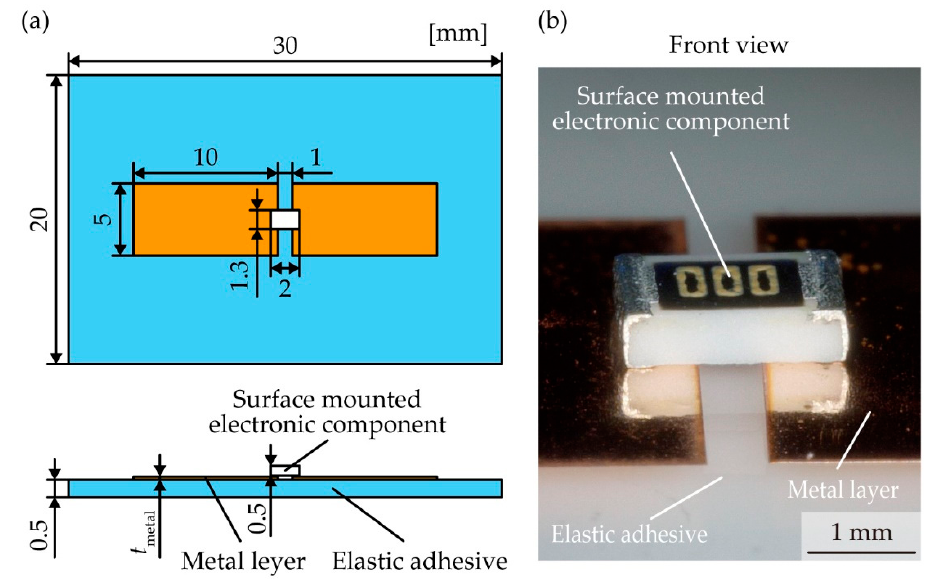
Figure 2. ( a ) Schematic images of experimental sample; ( b ) optical image of sample.